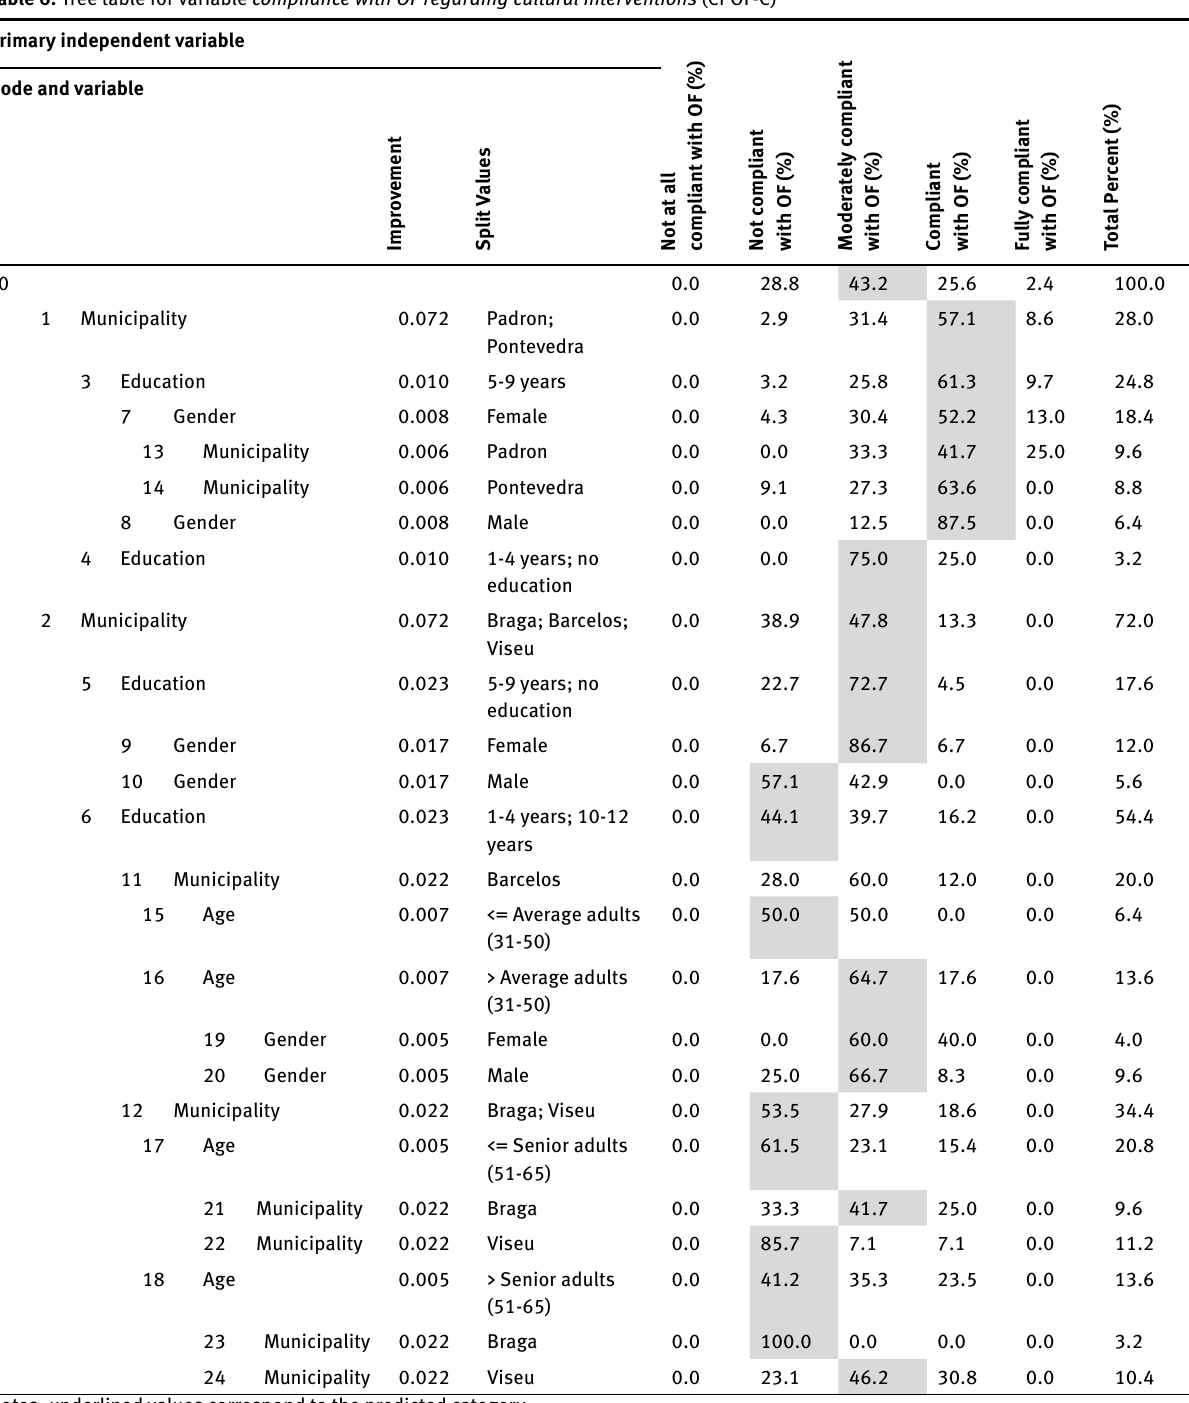
Table 6: Tree table for variable compliance with OF regarding cultural interventions (CPOF-C) Primary independent